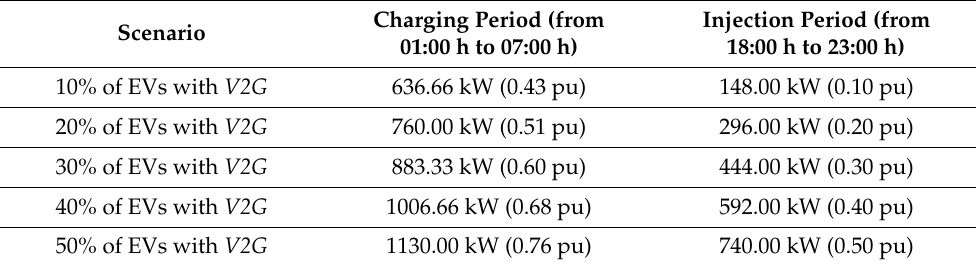
Table 3. Power requirements in EVs scenarios with V2G connection (calculations for each